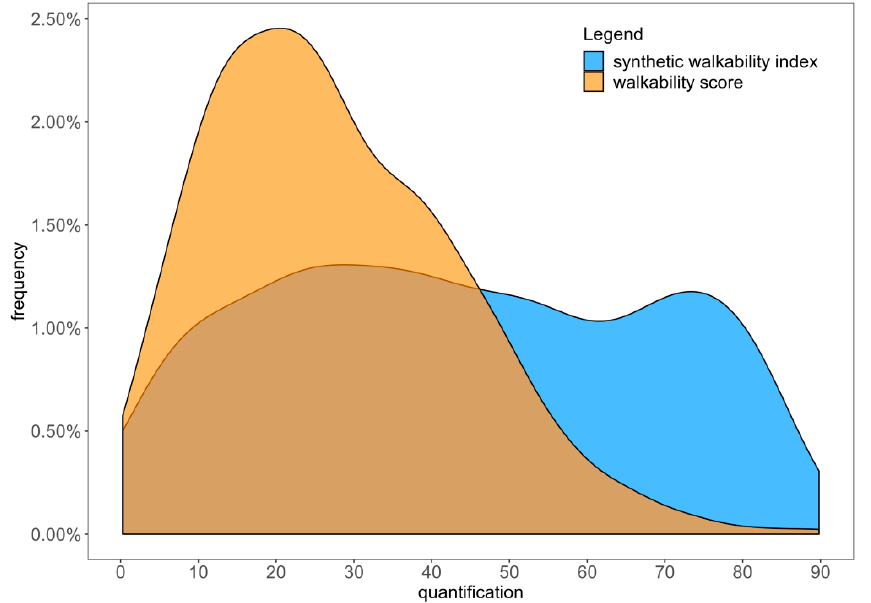
Figure 6. The distributions of synthetic walkability index (blue) and Walk Score (orange) with the same random samples in Binghamton.